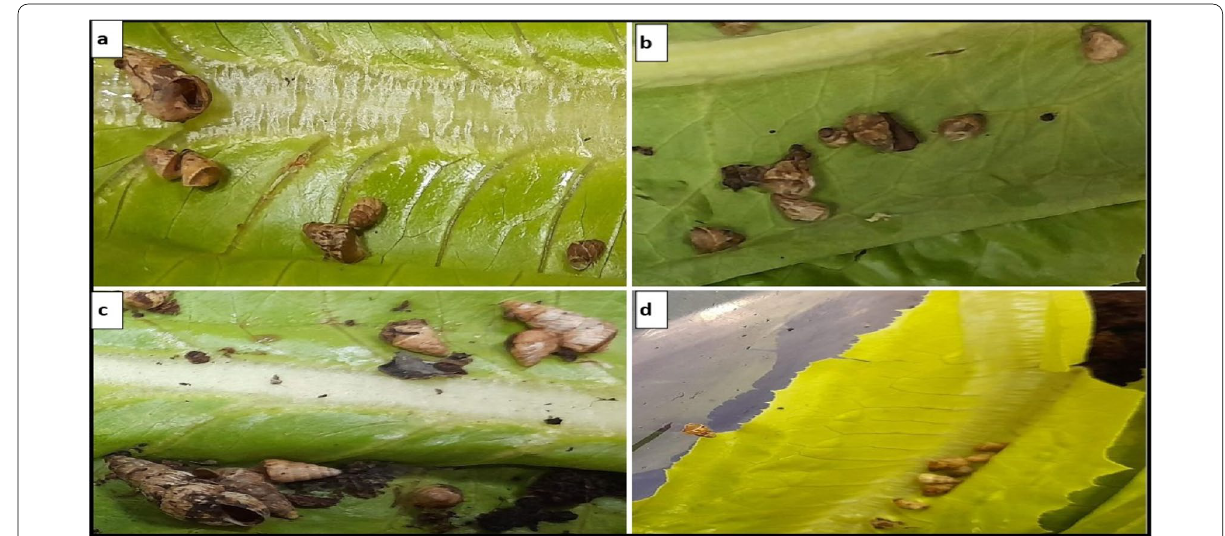
*Means under each concentration sharing the same letter in a column are not significantly different at P < 0.05